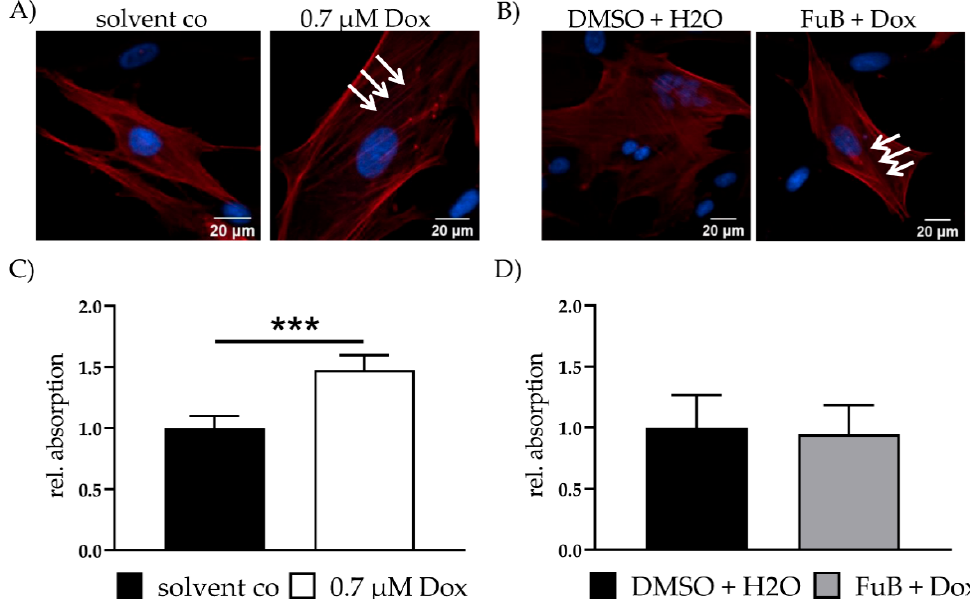
Figure 5. Fibrosis—ACTA2 expression and collagen production. ( A ) Fibrosis marker ACTA2 was visualized with IF. ACTA2 was stained red. Nucleus was stained blue. Dox treated cells show more defined ACTA2 filaments (white arrows). ( B ) Fibrosis marker ACTA2 was visualized with IF. ACTA2 was stained red. Nucleus was stained blue. FuB + Dox treated cells still show more defined ACTA2 filaments (white arrows). ( C ) Collagen in the cell supernatant was measured after Dox treatment, followed by 72 h growth medium incubation. ( D ) Collagen in the cell supernatant was measured after FuB followed by Dox treatment and additional 72 h growth medium. Depicted are the mean values and standard deviation of minimum three biological replicates. Significances were calculated with a t -test. (*** p ≤ 0.001).